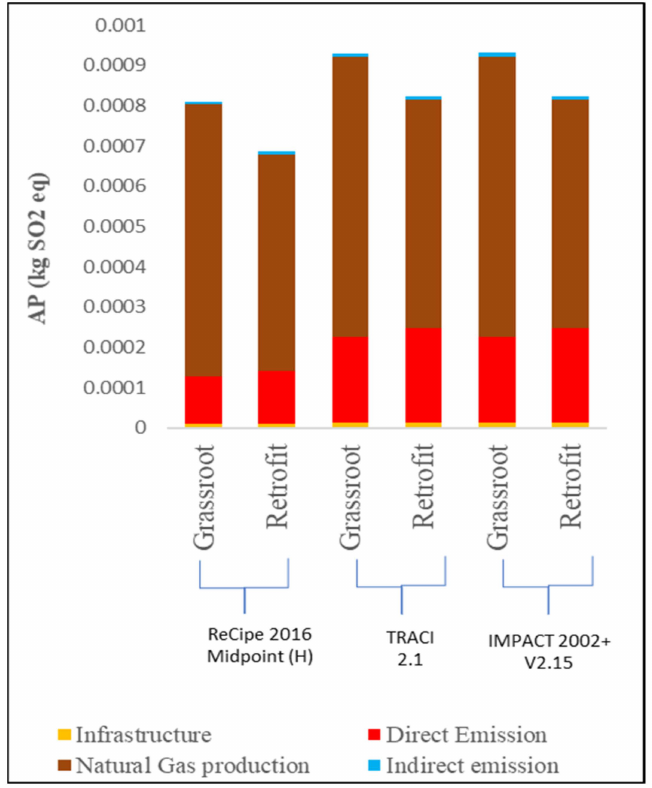
Figure 7. AP Impact score and process